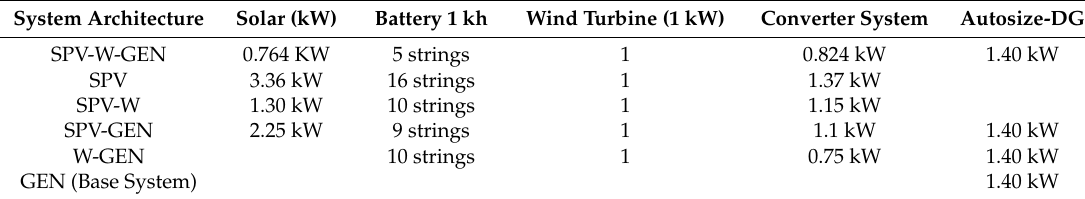
Different architecture with corresponding solar, battery, wind turbine, converter system, autosize-DG. System